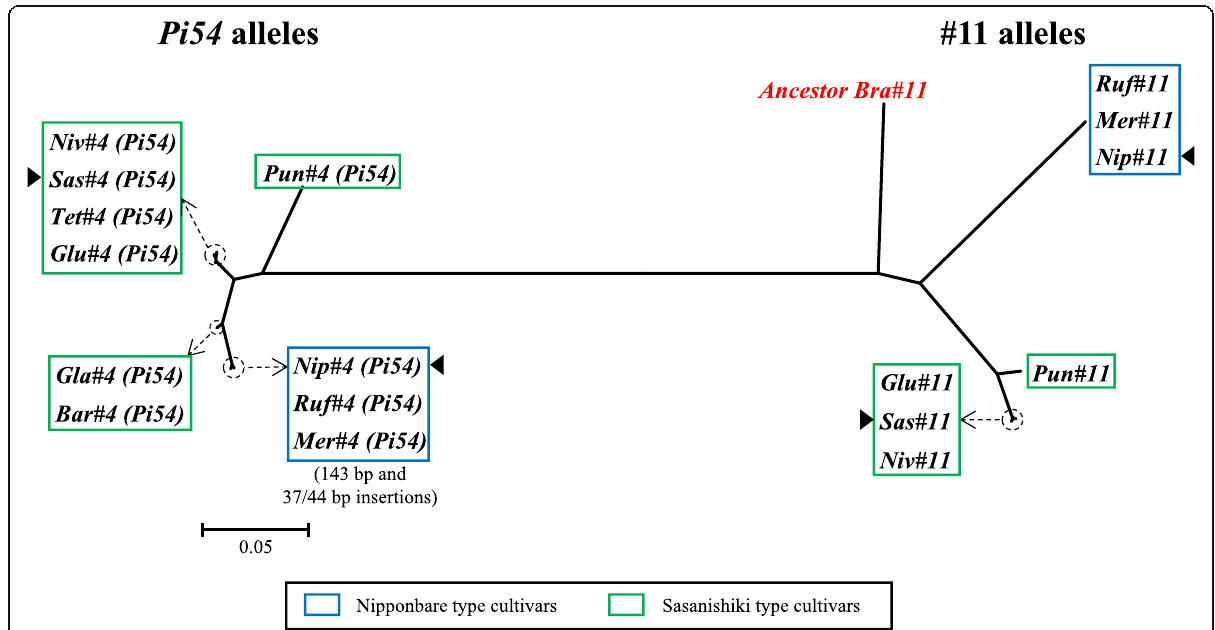
Fig. 5 A maximum-likelihood phylogenetic tree showing relationships among the alleles of the Pi54 and #11 genes. The tree contains 18 genomic DNA sequences both coding and non-coding. Sequences of 10 Pi54 alleles were extracted according to the functional Pi54 sequence in Tetep. Sequences of 8 alleles of #11 are complete coding DNA sequence (CDS). Nip, Nipponbare; Sas, Sasanishiki; Tet, Tetep; Glu, O. glumaepatula ; Niv, O. nivara ; Bar, O. barthii ; Gla, O. glaberrima ; Ruf, O. rufipogon ; Mer, O. meridionalis ; Pun, O. punctata ; Bra, O. brachyantha . Locations of Pi54 alleles on chromosome 11: Nip, 25,263,336